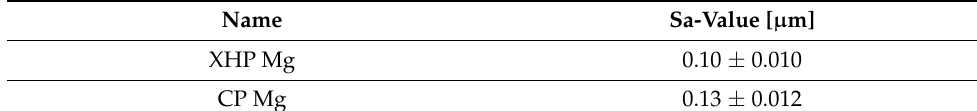
Figure 4. Microscopic appearance of etched surfaces of XHP (left) and cp (right) magnesium. Table 2. Surface roughness.